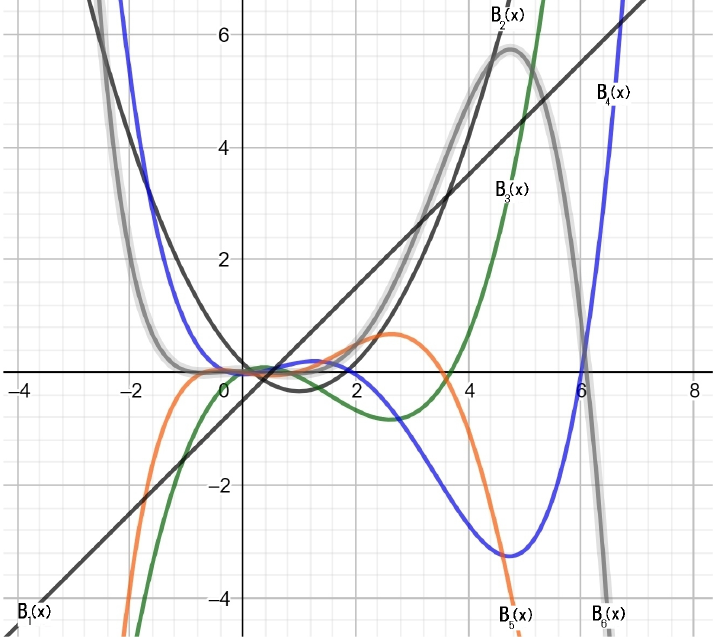
Figure 1. Graphs of polynomials L B n ( x ) for n = 1,2, . . .